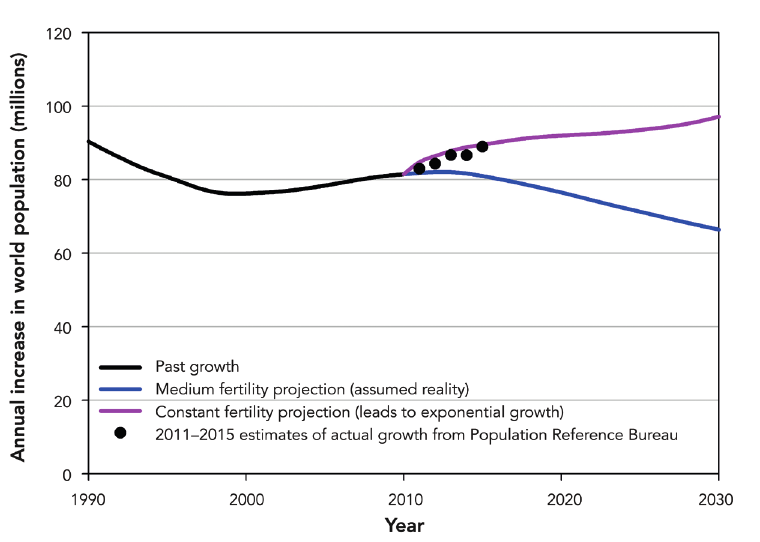
Figure 2. How have we tracked since the last projection? The annual increment of global population from 1990 to 2010 (black), and those projected in the UN’s 2012 revision of the medium fertility projection (blue) and the constant fertility projection (pink) (UNDESA 2013). With the latter, in which each country’s fertility is held constant, world population grows to reach 28 billion in 2100 (unless checked by famine and war). Superimposed are the estimates of actual increase from the Population Reference Bureau’s annual World Population Data Sheets, from 2011 to